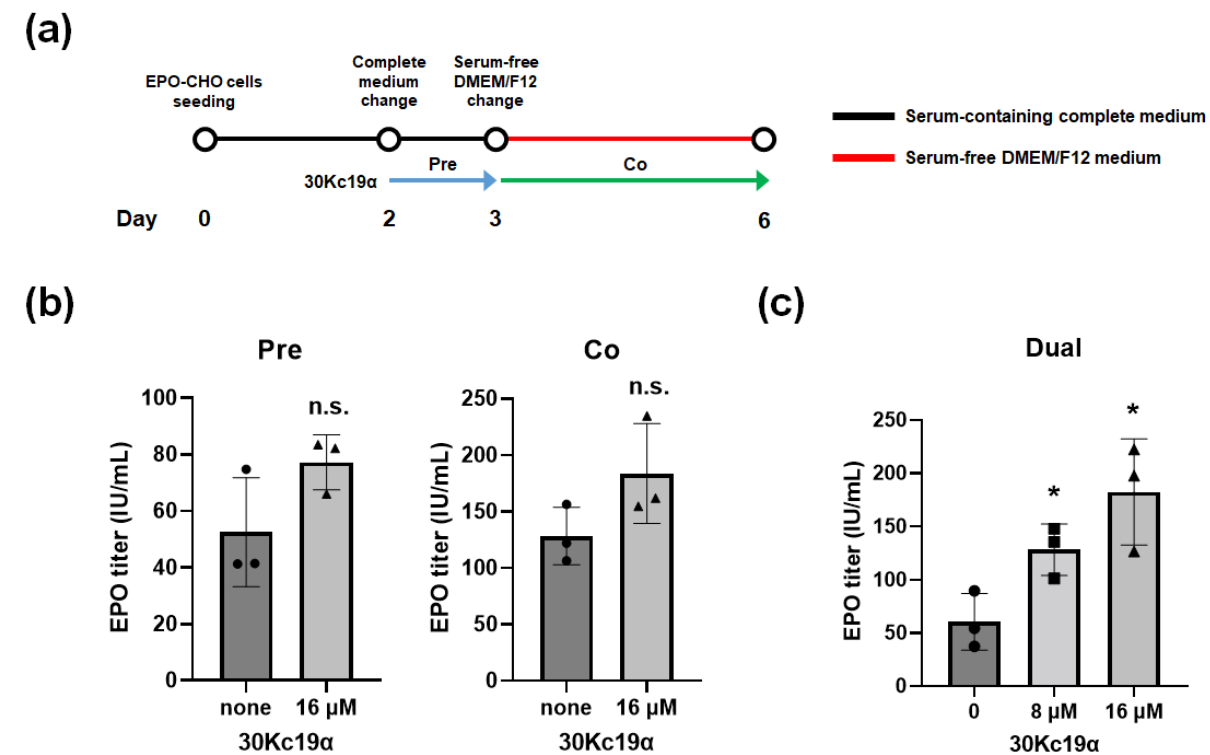
Figure 4. Effects of 30Kc19 α treatments on rhEPO production in CHO cells. ( a ) Schedule for the treatment with 30Kc19 α of EPO–CHO cells. Conditioned media of cell cultures treated ( b ) once (pretreated and cotreated) and ( c ) twice (dually treated) with 30Kc19 α were collected on day 3 of culture in serum-free medium. Titers of rhEPO were determined with an enzyme-linked immunosorbent assay (ELISA). Error bars indicate standard deviations ( n = 3 per group). Statistical significance was determined using Student’s t -test. *, p < 0.05; n.s., not significant compared to the nontreated control.